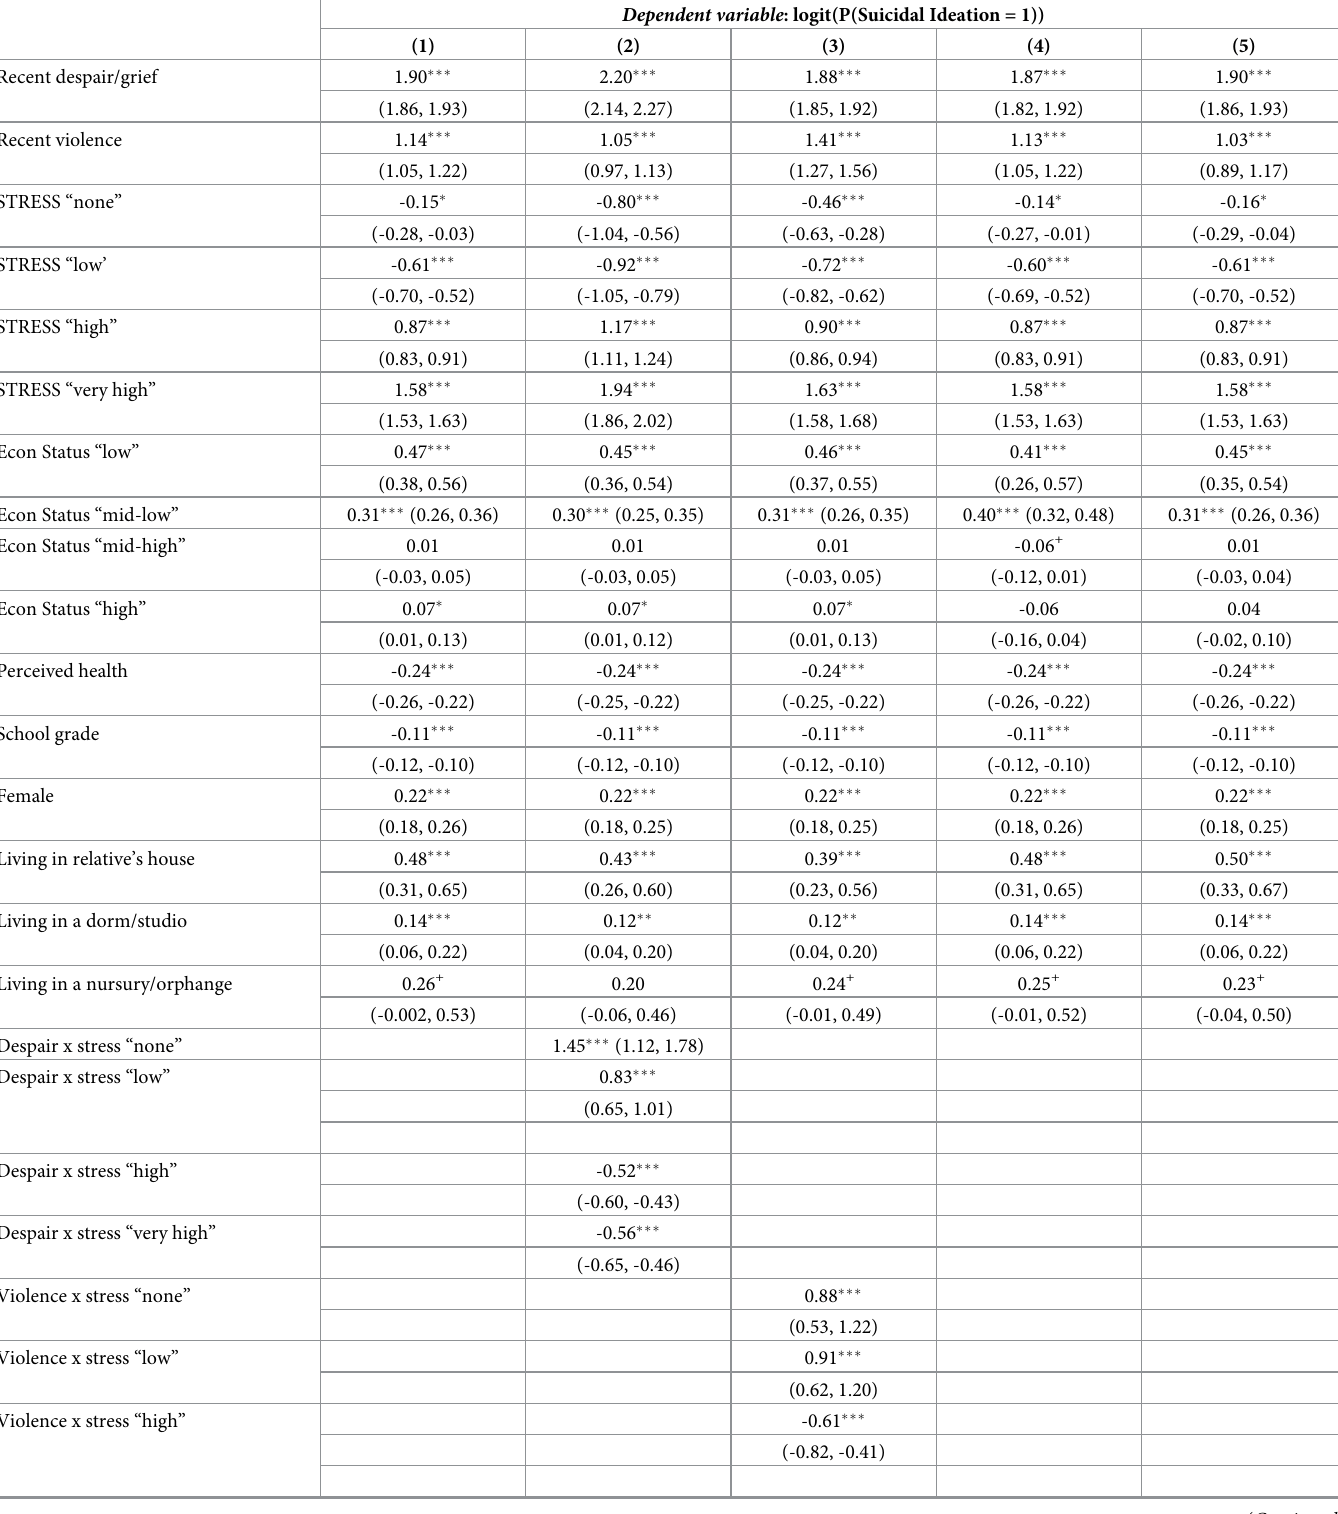
Table 2. Population-averaged models,